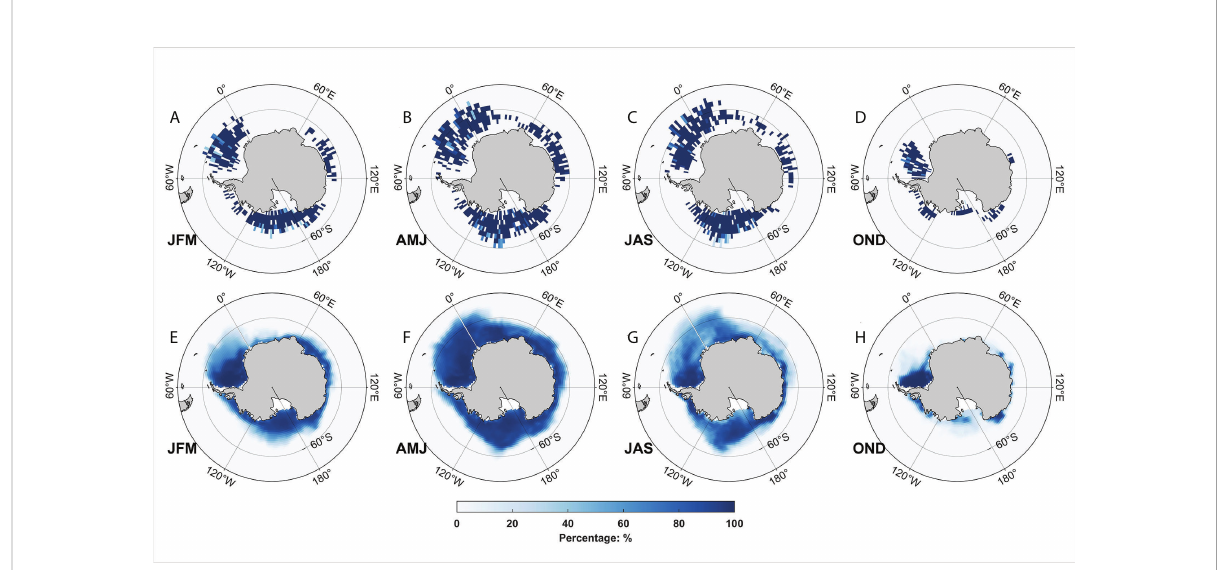
FIGURE 7 Sea ice around the Antarctica from January 2016 to December 2016. Sea ice coverage detected by KECANet in seasons: January-February- March (JFM), April-May-June (AMJ), July-August-September (JAS) and October-November-December (OND) are shown in (A-D) with color denoting the occurrence percentage in 2° × 2° boxes. (E-H) show the mean sea ice concentration from the NSIDC monthly